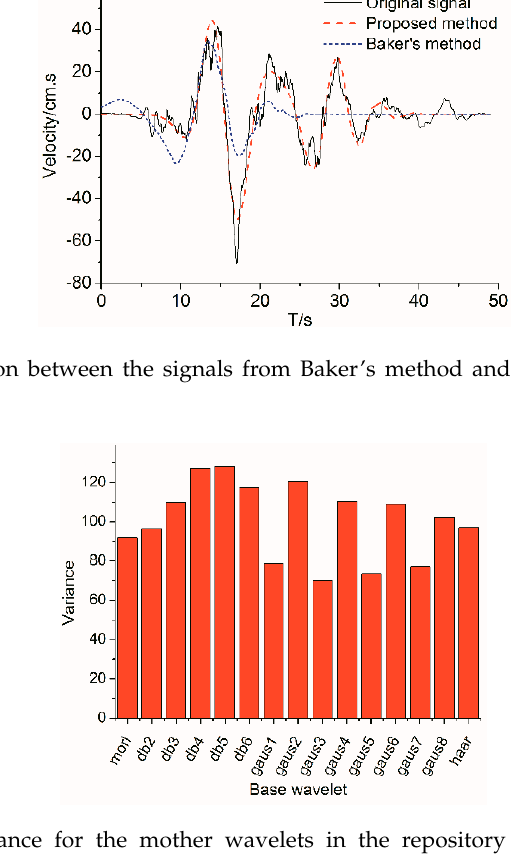
Figure 12. The variance for the mother wavelets in the repository before extracting the p (cid:2869) pulse